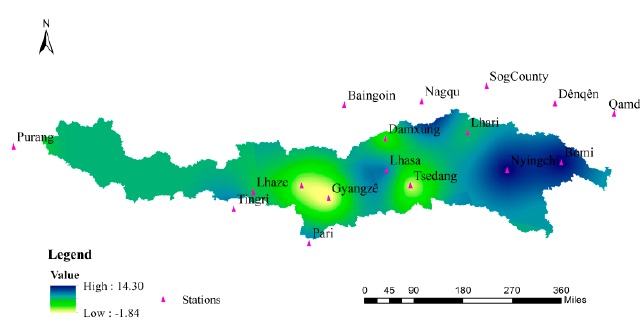
Figure 7. Covariability of the mean air temperature and precipitation of the basin.